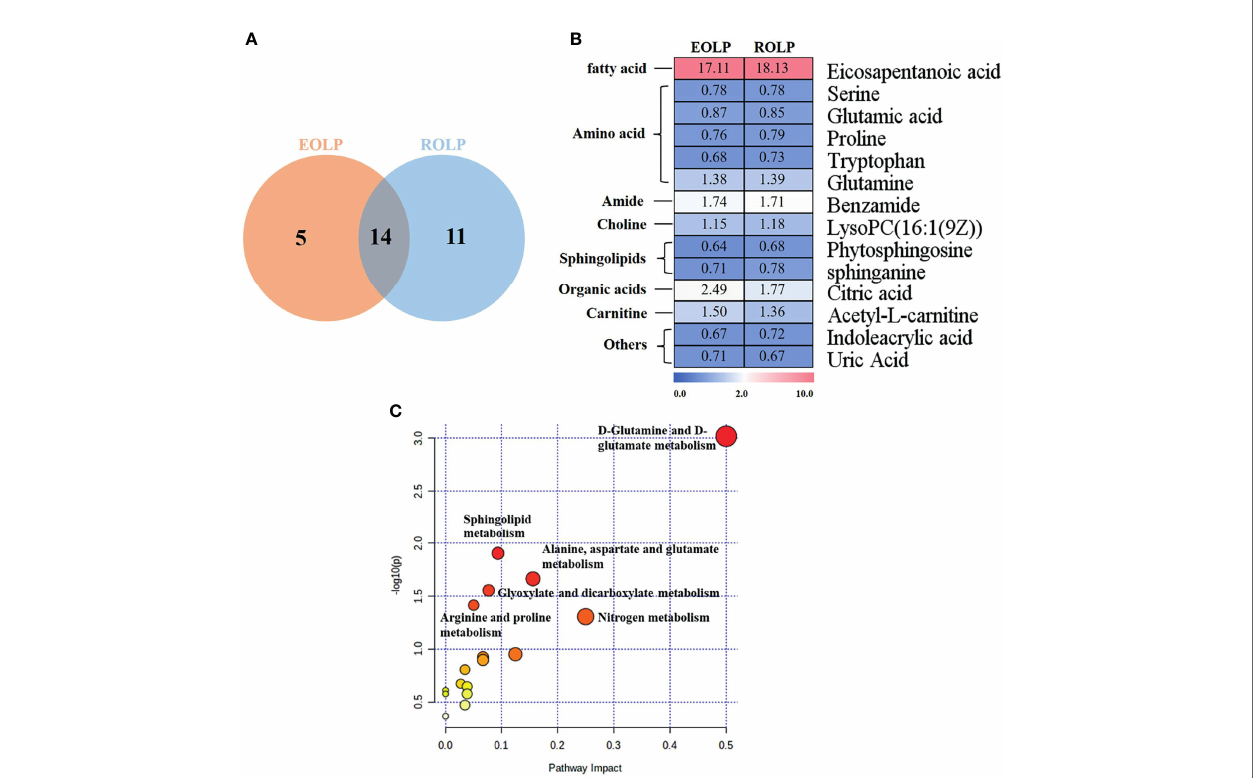
FIGURE 5 | Venn diagram of EOLP and ROLP metabolites overlapped (A) , Fold change analysis (red, up-regulated; blue, down-regulated) (B) , Metabolism pathway diagram of common metabolites in EOLP and ROLP groups (C) .